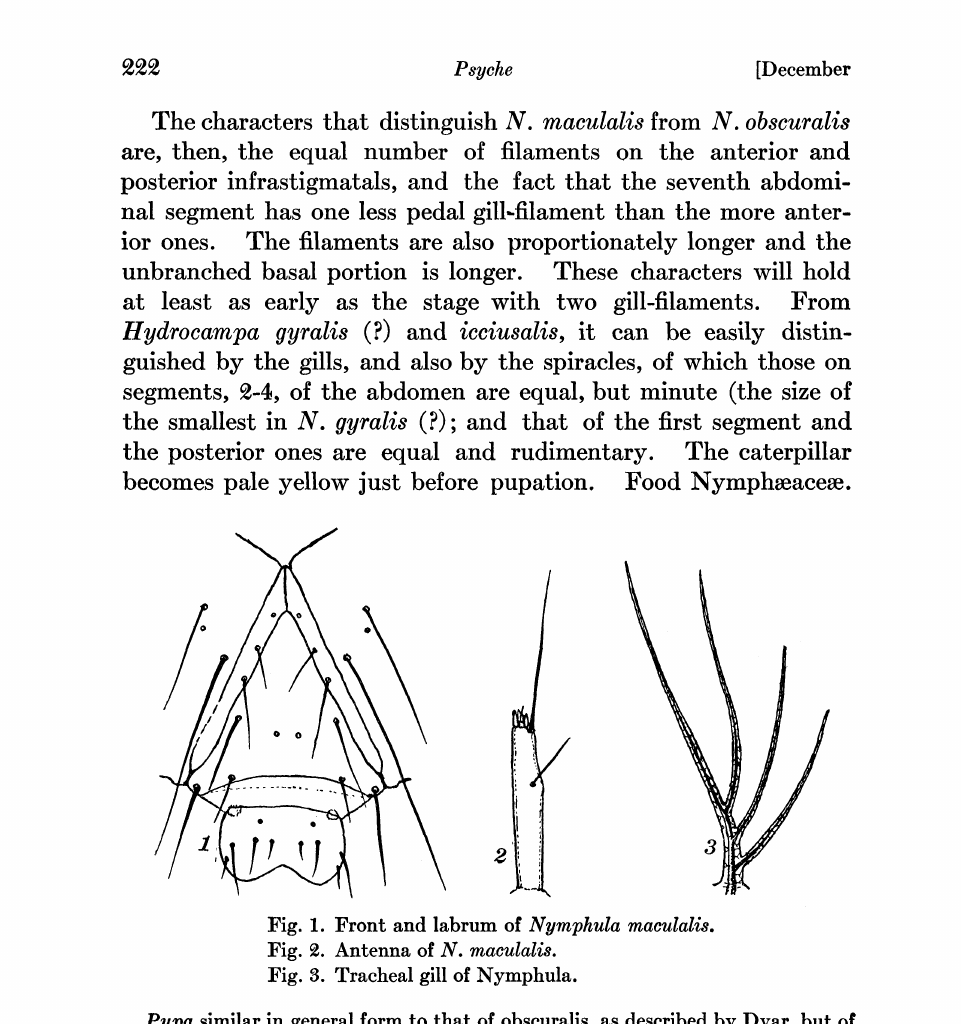
Fig. 1. Front and labrum of Nymphula maculalis. Fig. 2. Antenna of N. maculalis. lig. 3. Tracheal gill of